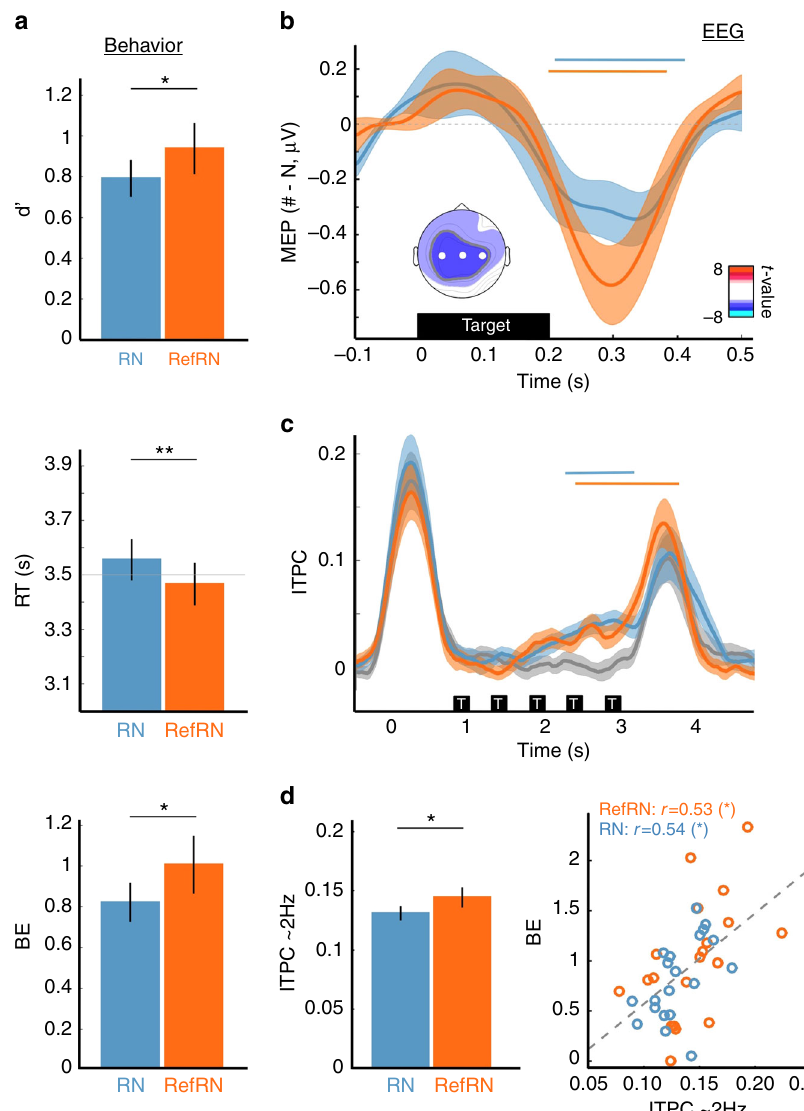
Fig. 2 Behavioral and electrophysiological indexes of perceptual learning in wakefulness. a Behavioral indexes of memory for noise. Participants could discriminate RN and RefRN from noise as indicated by the positive sensitivity ( d ′ , top ). In addition, performance was better for RefRN compared to RN: d ′ was increased while reaction times (RTs, middle ) were decreased for RefRN. We combined these two variables into a Behavioral Ef fi cacy (BE, bottom ) index. Error bars denote the standard error of the mean across participants ( N = 20). Stars atop graphs refer to the RefRN vs. RN comparison (paired t-test, here and below: P < 0.01: **; P < 0.05: *). b Target-locked memory-evoked potentials (MEPs). Averaged EEG activity time-locked to the position of targets ’ onset for RefRN ( orange ), RN ( blue ) compared to N trials during the pre-sleep phase. All targets but the fi rst one from a given trial were used to compute these MEPs (4 targets per trial). MEPs were temporally smoothed using a 50 ms-wide Gaussian kernel. Shaded areas denote the SEM across participants. Horizontal orange and blue lines show signi fi cant clusters for the RefRN vs. N ( orange , [200, 400] ms post target) and RN vs. N ( blue , [200, 410] ms) comparisons ( P cluster < 0.005). The inset shows the scalp topographies of t -values corresponding to the RefRN vs. N cluster (i.e., t -values obtained via a t - test of the RefRN vs. N difference for the MEPs waveforms averaged between 200 and 400ms across participants). White dots show the central electrodes used in b – d . c Stimulus-locked Inter-Trial Phase Coherence (ITPC). An increase in ITPC ([1.5, 3.5] Hz) was observed for RefRN ([2.3, 3.8]s post stimulus onset, P cluster < 0.05) and RN trials ([2.2, 3.1]s, P cluster < 0.05) compared to N. ITPC was here corrected for baseline activity ([ − 1.3, − 0.3]s). d